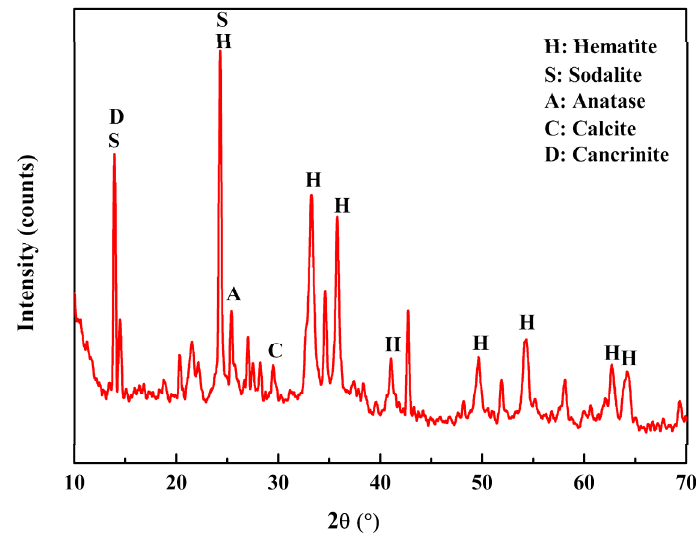
Figure 1. XRD pattern of the Bayer red mud.